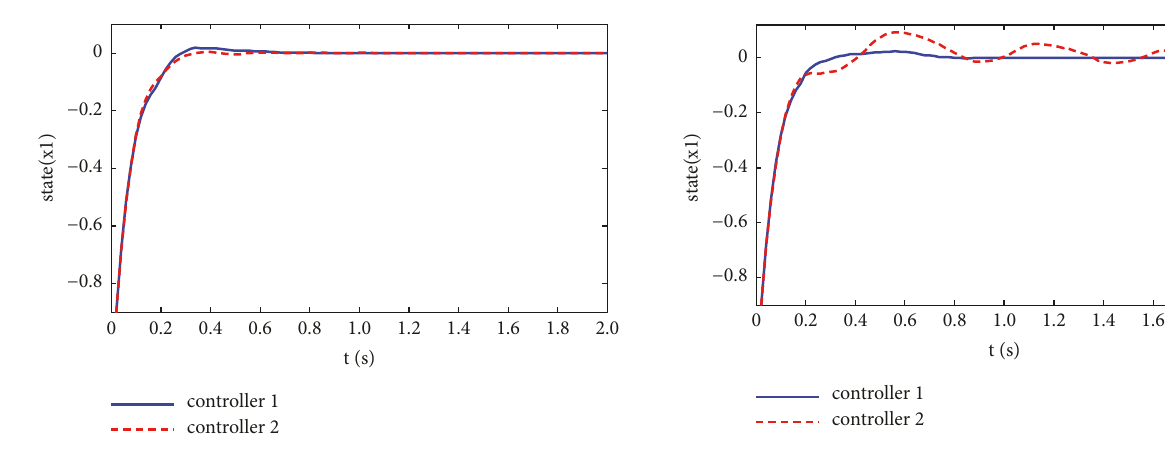
Figure 9: Trajectory of state 𝑥 1 with two controllers on condition 𝜏 = 2,𝜌 = 2 .